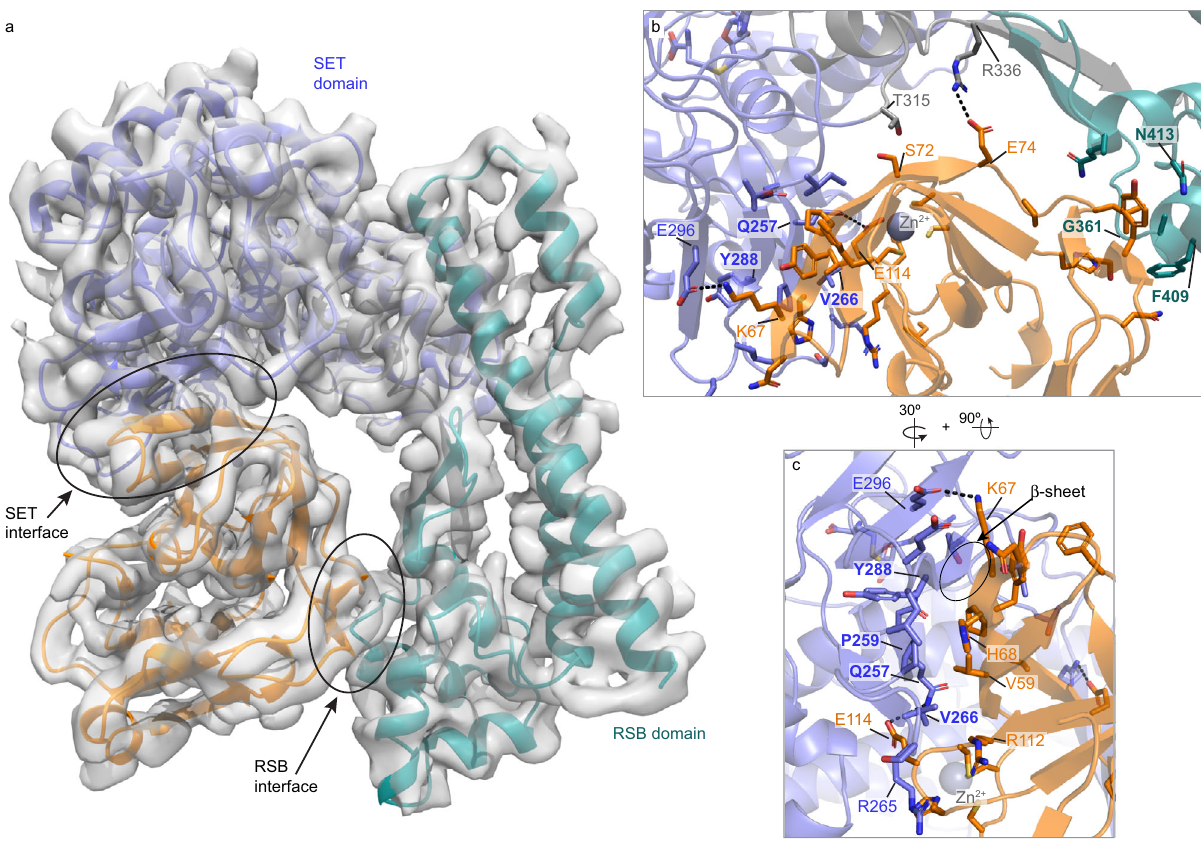
Fig. 2 | StructureofCV-B32Aand SETD3 in complex. a Cryo-EM map and ribbon representationofSETD3-2Acomplex.TheSETdomainofSETD3isshowninpurple, the linker in grey, the RSB domain in cyan, and CV-B3 2A protease in orange. See alsoSupplementaryTables1and2,SupplementaryFigs.2 – 4. b , c Expandedviewsof